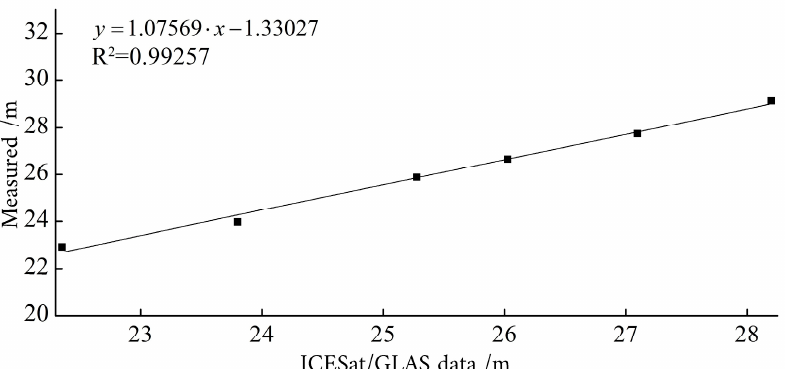
Figure 9. Ice, Cloud, and Land Elevation Satellite’s Geoscience Laser Altimeter System data and elevation data correlation analysis.